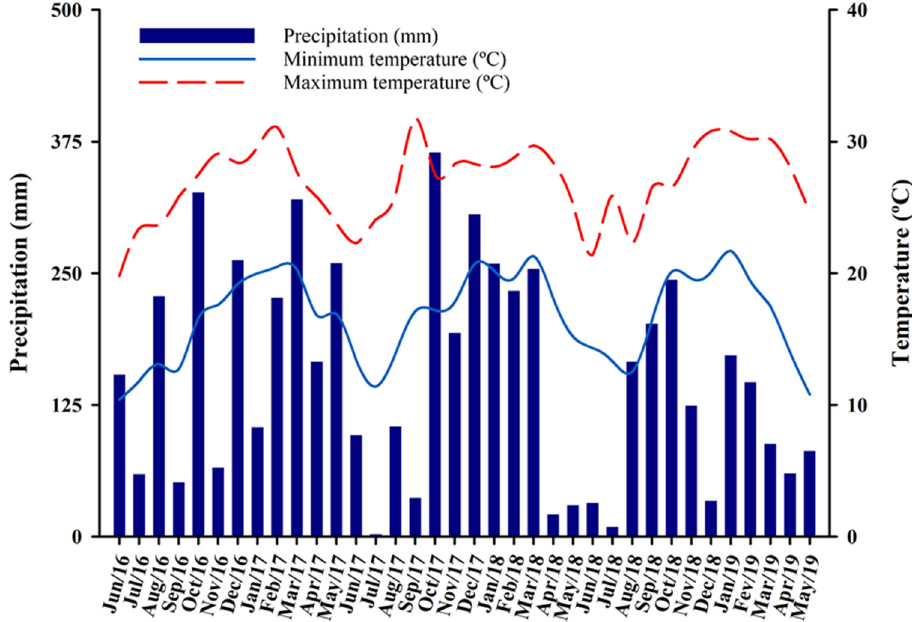
Figure 2. Minimum and maximum temperatures (°C) and precipitation (mm) for the experimental area (June 2016 to May 2019).